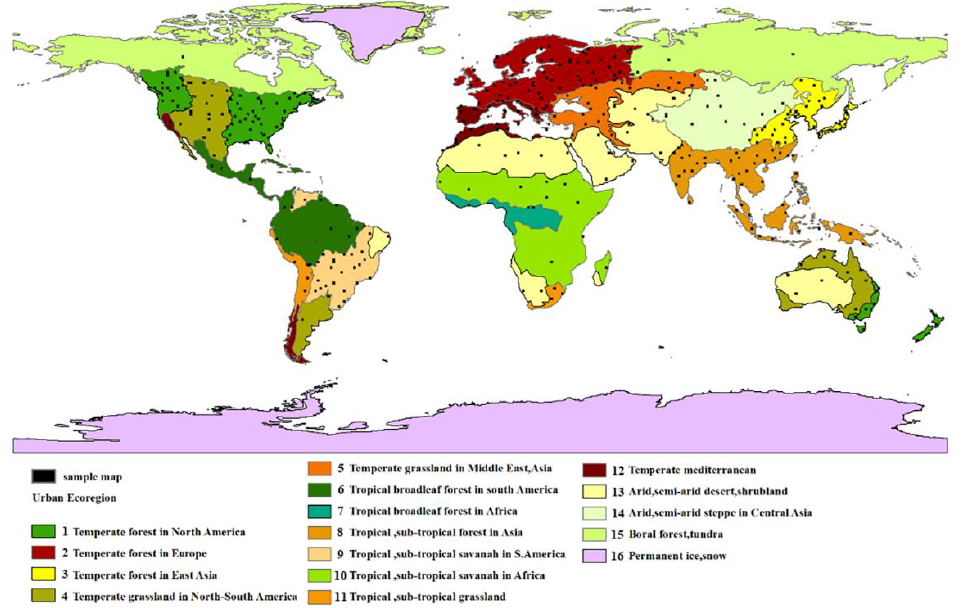
Since the number of samples for the map sheets in each ecoregion was determined according to the area percentage, the inclusion probabilities for the map sheet samples in each ecoregion are similar. In each geographic stratum, the PSUs were selected randomly in consideration of the criterion of the stratified random sampling design. Figure 8 shows the result of the distribution of the sample map sheets for the multi-temporal urban land-cover data at a global scale.